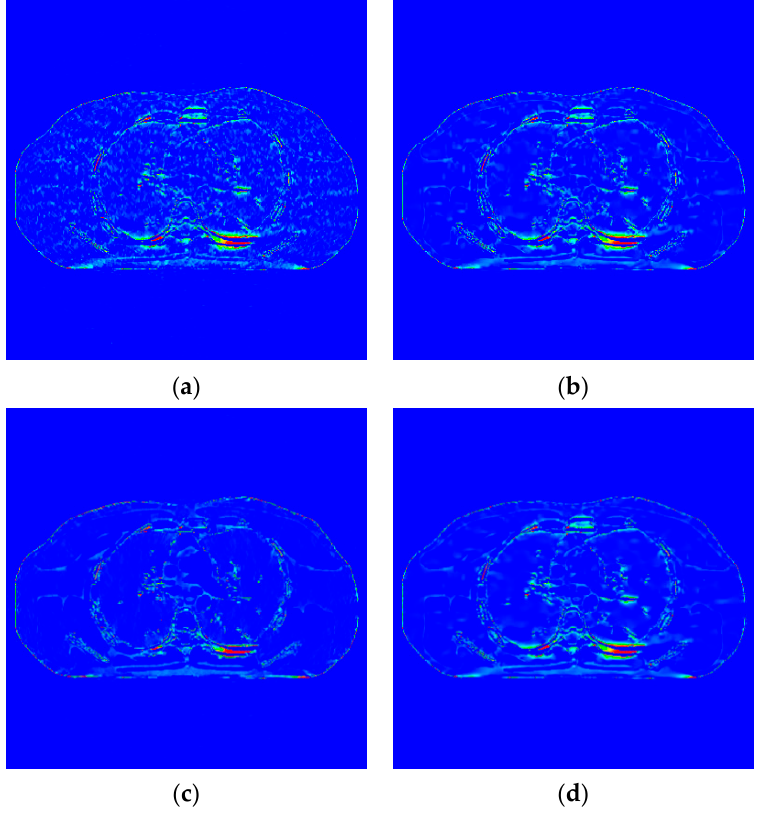
Figure 9. Image of difference of incident photon number 10 4 . ( a ) EP iterative reconstruction differ- ence map; ( b ) DCT image post-processing; ( c ) DL iterative reconstruction algorithm; ( d ) learning sparse variation.